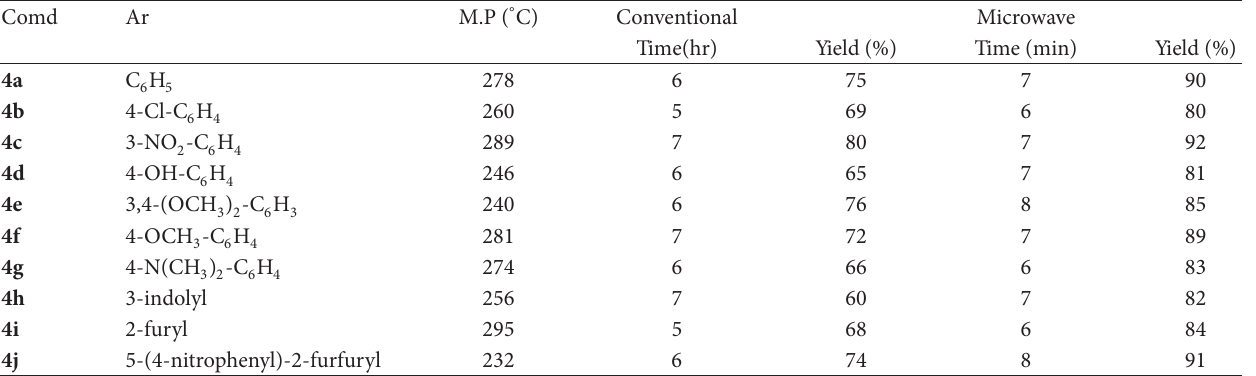
T 1: Characterization data of compounds 4(a–j) .